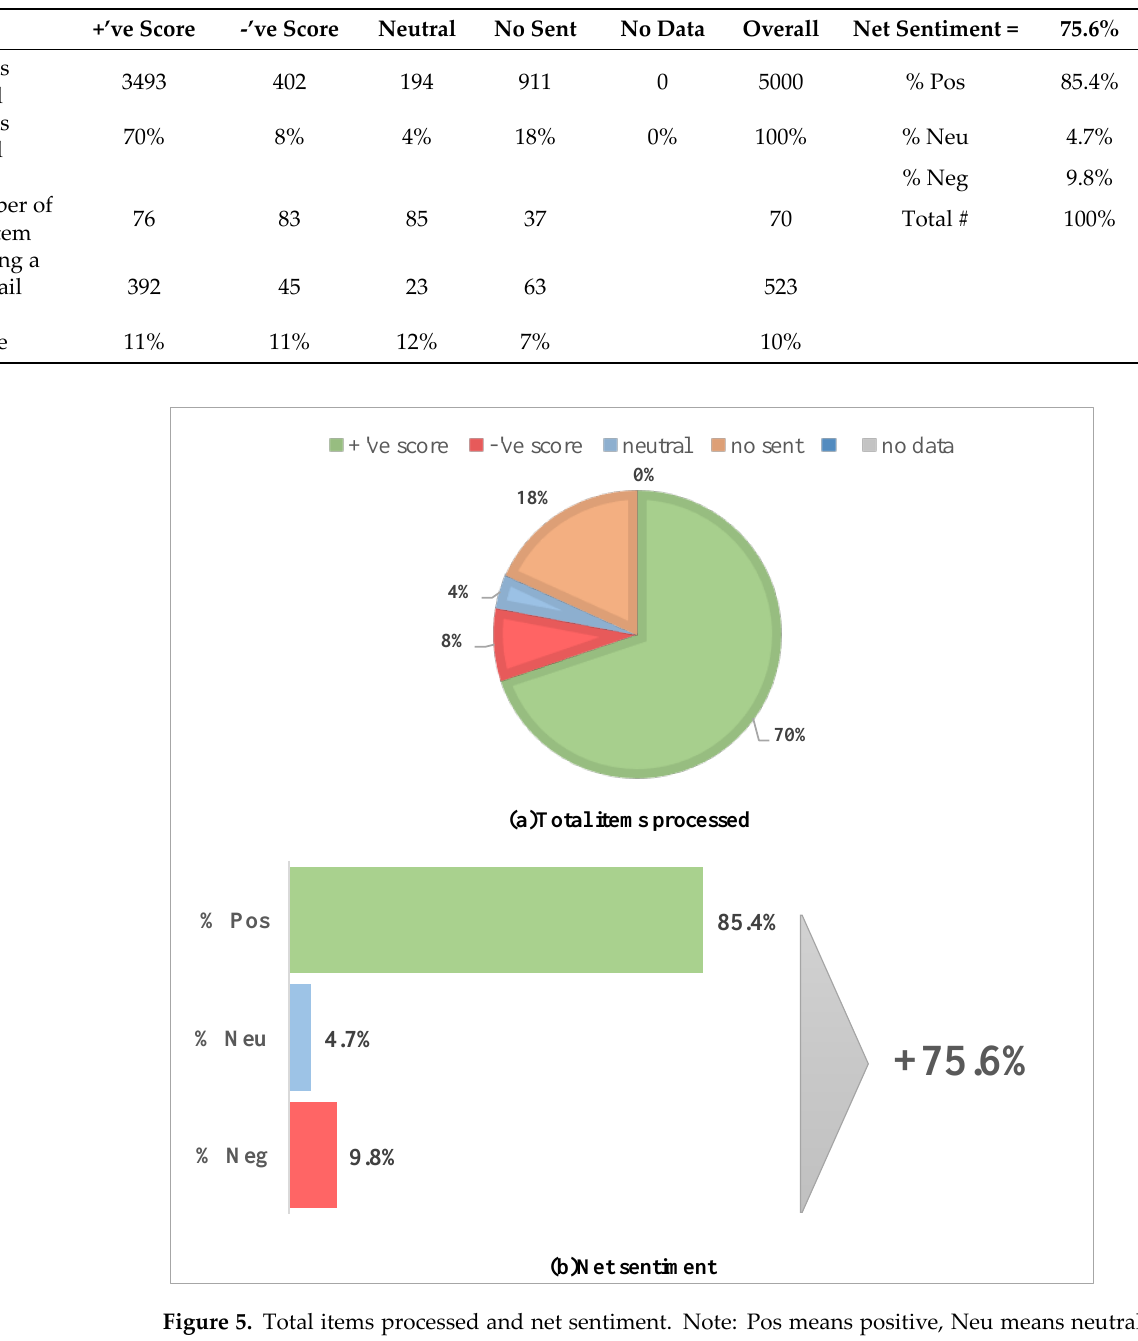
Figure 6. Average number of words per item of text and percentage containing a URL or email ad- dress.